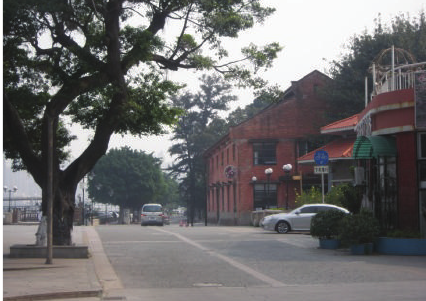
Figure 3: Riverside view.